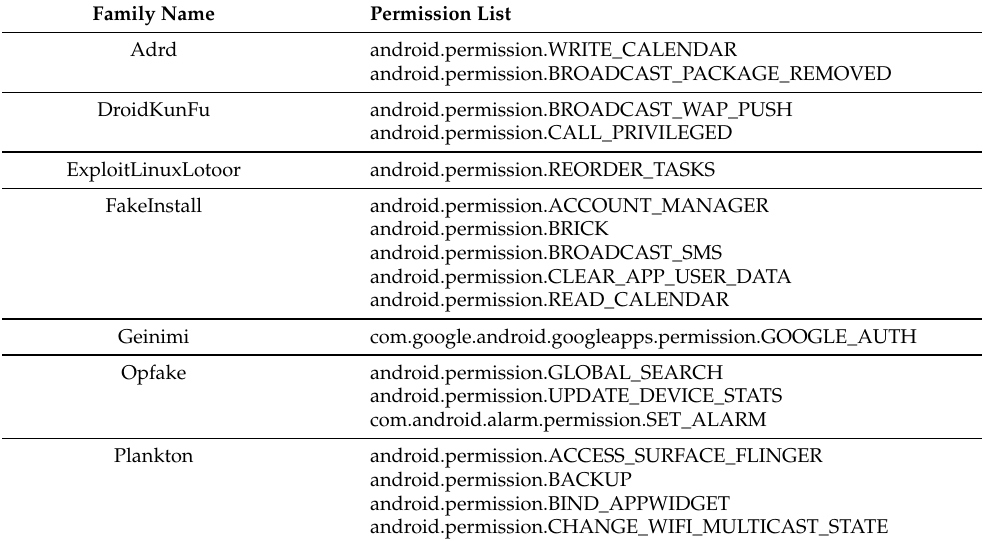
Table 5. Permissions requested only by a specific